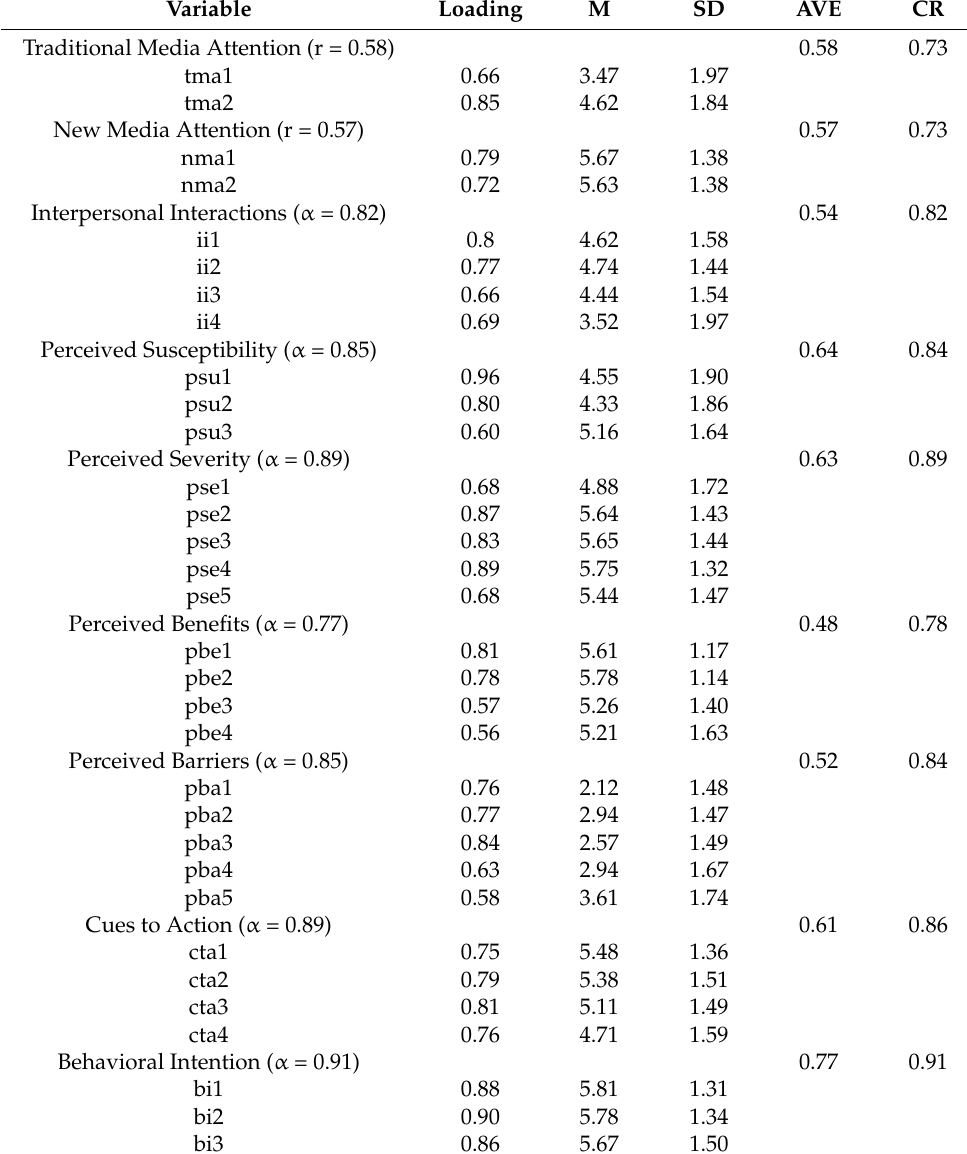
Table 3. Summary of measurement items ( n = 621 ). Variable Loading M SD AVE CR Traditional Media Attention (r = 0.58) 0.58